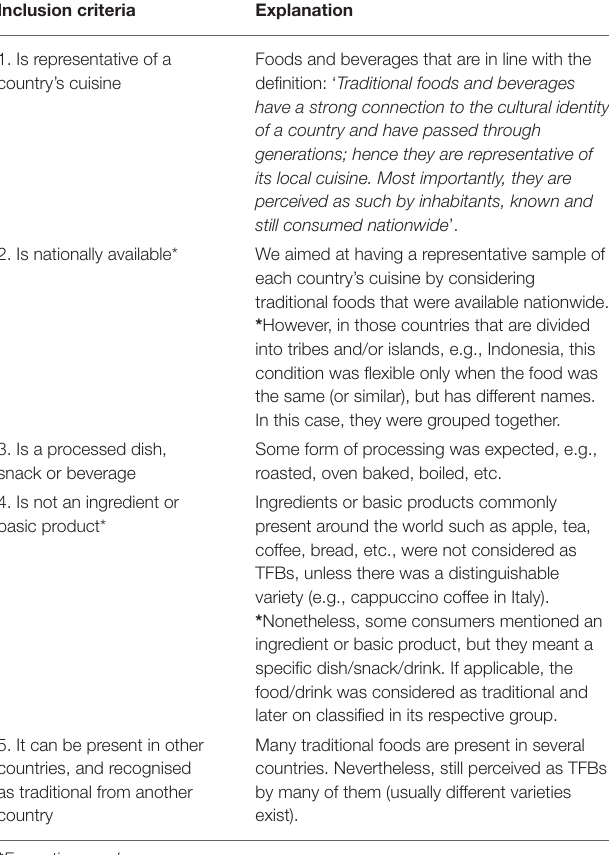
TABLE 1 | List of criteria used for the operationalisation of the traditional foods and beverages concept. Inclusion criteria